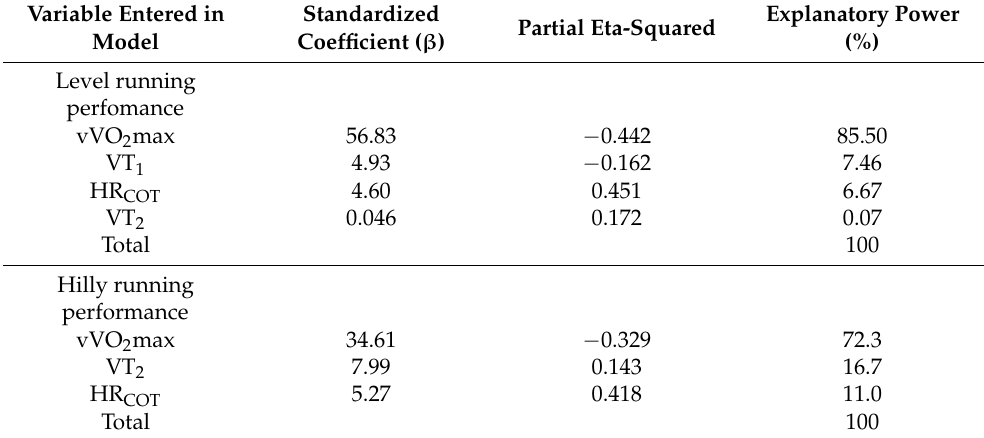
Table 3. Multiple linear regression using cardiorespiratory parameters from level tests for level running performance and using cardiorespiratory parameters from incline tests for hilly running performance ( p <